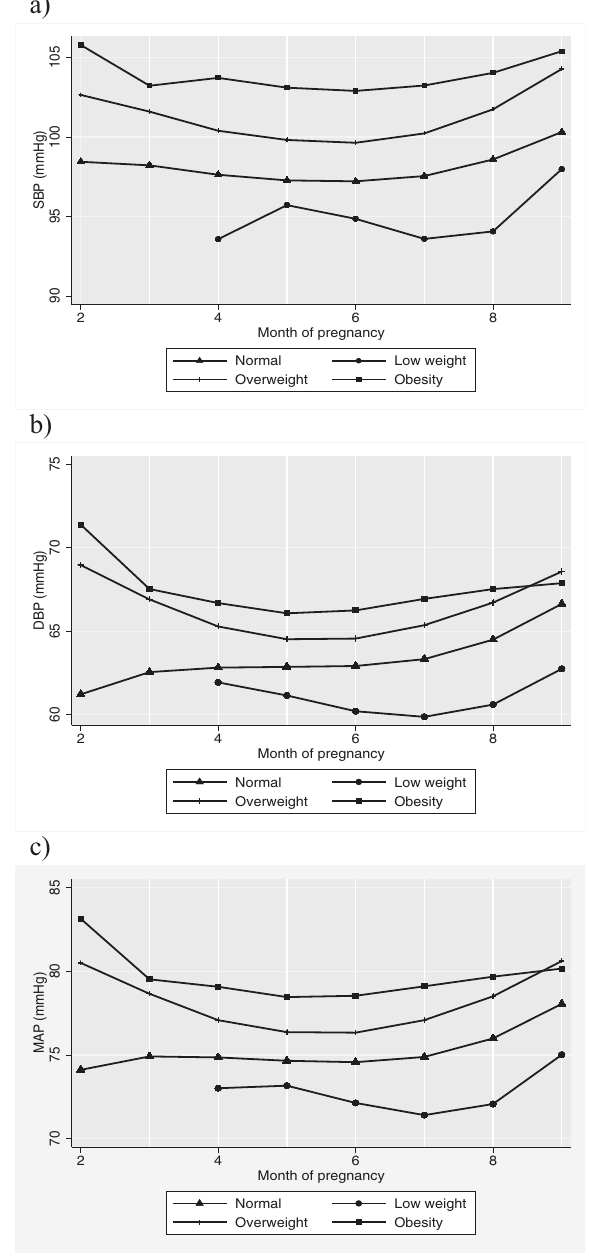
Fig. 1 Adjusted TC, TG, and glucose trajectories through pregnancy by pBMI groups. a Adjusted TC trajectories by pBMI groups. b Adjusted TG trajectories by pBMI groups. c Adjusted glucose trajectories by pBMI groups. pBMI pre-pregnancy body mass index, TC total cholesterol, TG triglycerides. Adjusted models controlled for: age, height, education, marital status, month of pregnancy, parity.